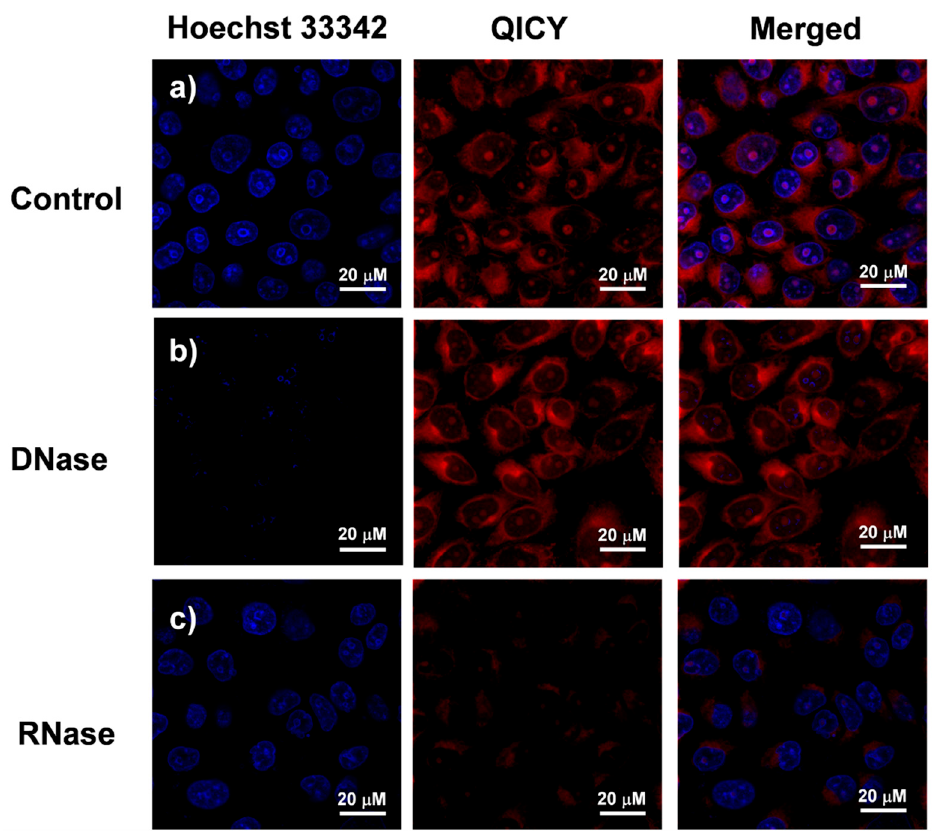
Figure 6. The fluorescence intensity of Hoechst 3342 and QICY in fixed MCF cells treated with RNase or DNase: ( a ) Control cell group; ( b ) DNase treatment group; ( c ) RNase treatment group stained with Hoechst 33,342 and QICY.